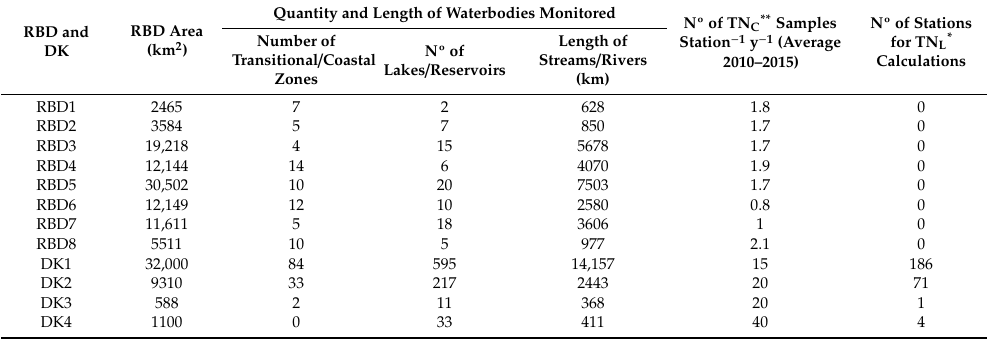
Table 1. Summary of features and water sampling criteria for Portuguese (RBD1–RBD8) and Danish (DK1–DK4) River Basin Districts (RBD) for the 2010–2015 WFD planning cycle [6,18,19]. RBD Area RBD and (km 2 DK